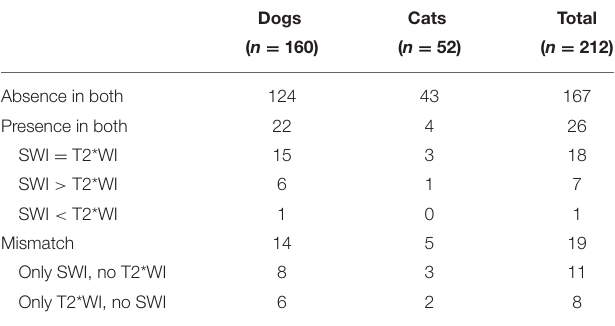
TABLE 2 | Comparison of image distortion (artifacts ordinally scored as mild, moderate, and severe) between susceptibility-weighted imaging and T2*-weighted imaging for species (dogs and cats) and subclasses defined by weight categories and skull conformation (Wilcoxon test, level of significance, p <